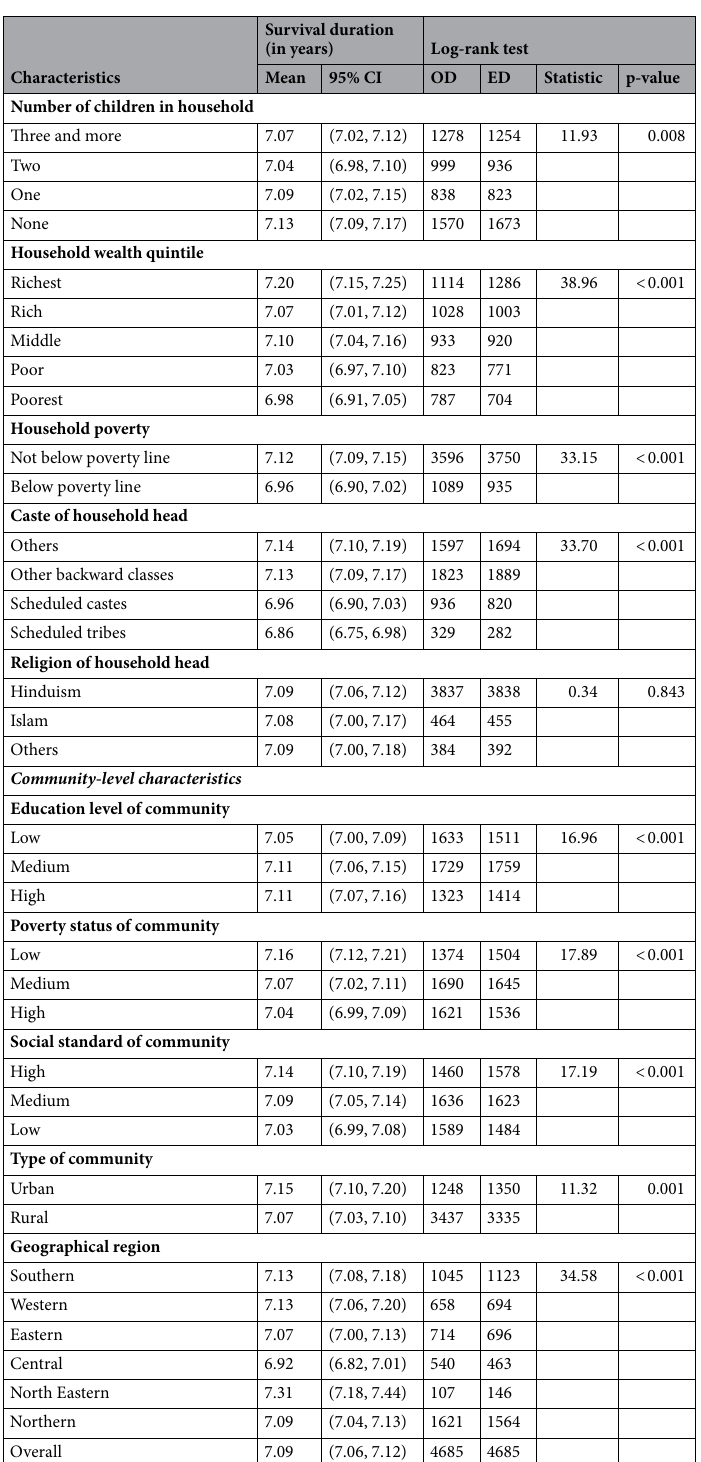
Table 2. Bivariate association of individual-level, family-level and community-level characteristics with mortality among older adults in India between 2005 and 2012. CI, confidence interval; OD, observed number of deaths; ED, expected number of